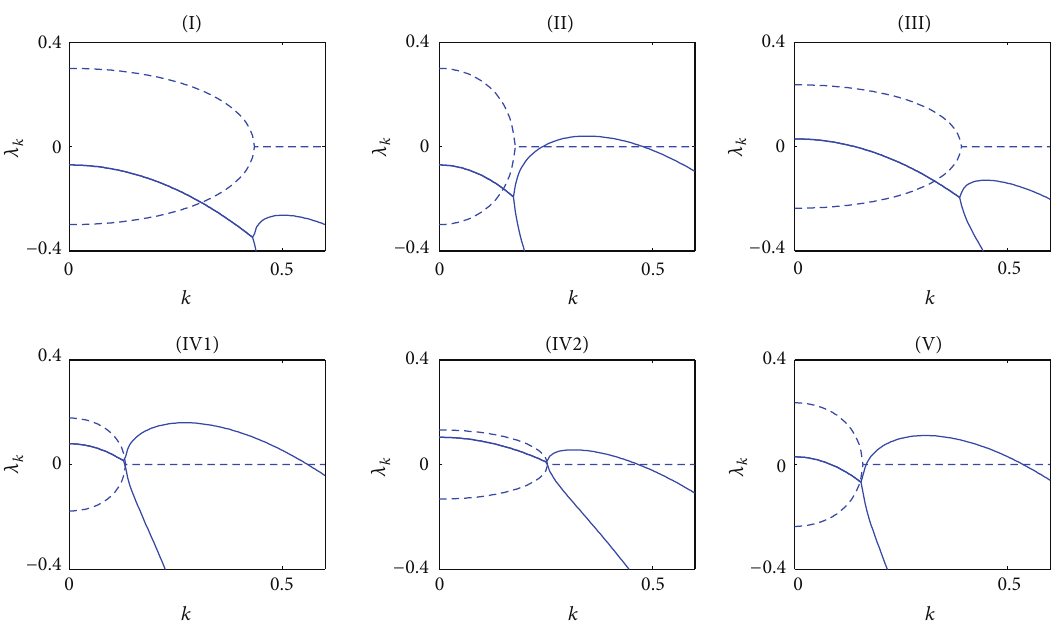
Figure 2: Dispersion relations: (I) (𝑑 2 ,𝛿) = (2,0.5) ; (II) (𝑑 2 ,𝛿) = (7, 0.5) ; (III) (𝑑 2 ,𝛿) = (2, 0.3) ; (IV1) (𝑑 2 , 𝛿) = (7,0.2) ; (IV2) (𝑑 2 ,𝛿) = ,𝛿) = (7, 0.3) . Solid line: the real parts of the eigenvalues; dashed line: imaginary parts of complex pair of eigenvalues. (2,0.15) ; (V) (𝑑 2